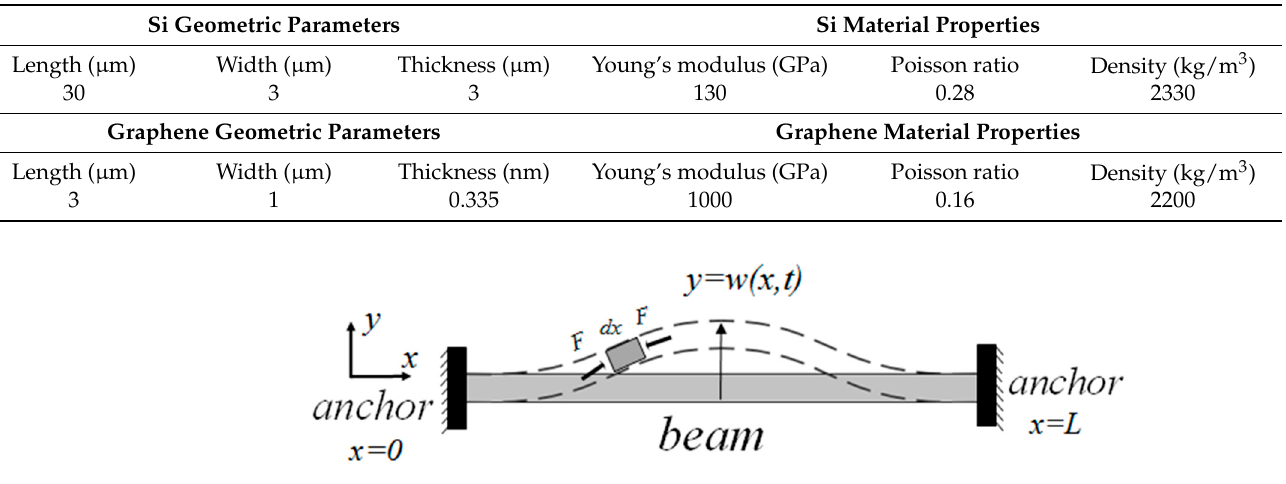
Figure 5. Bending model of graphene resonant beam subjected to force. The length, width, and thickness of the graphene resonant beam are L , b , and h , respectively. The microelement d x was chosen as the object of study; y ( x , t ) is the